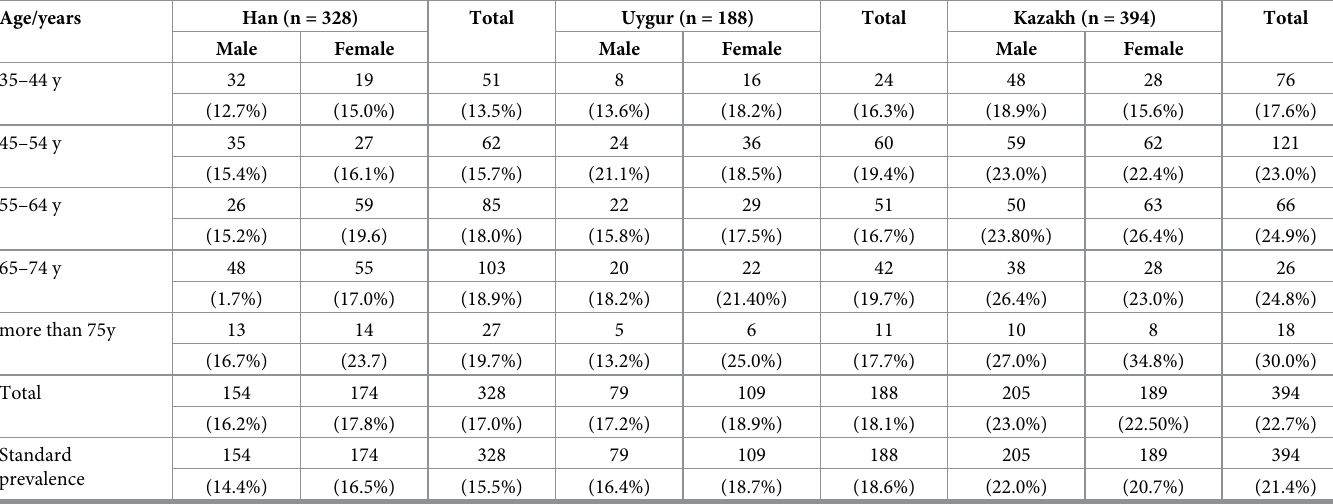
Differences were observed among the three groups in the hypertensive population ( χ 2 = 70.35, P < 0.01). A significant difference was observed in the prevalence of IAD among different age groups ( χ 2 = 10.76, P =